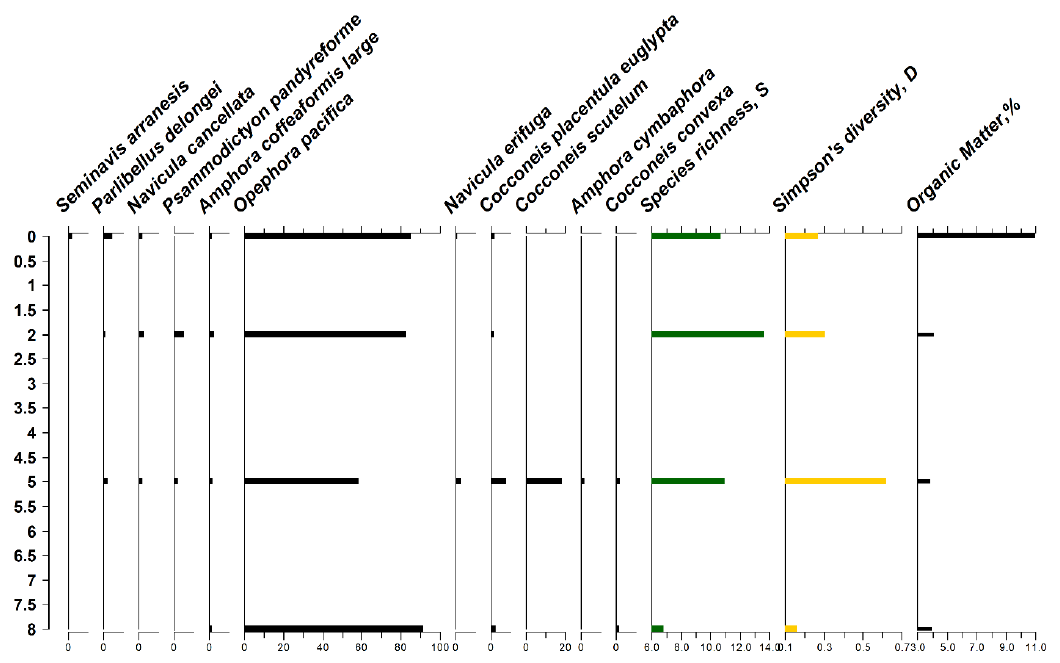
Figure 4. Diatom taxa occurring at above 1% at the sediment core from location 5.